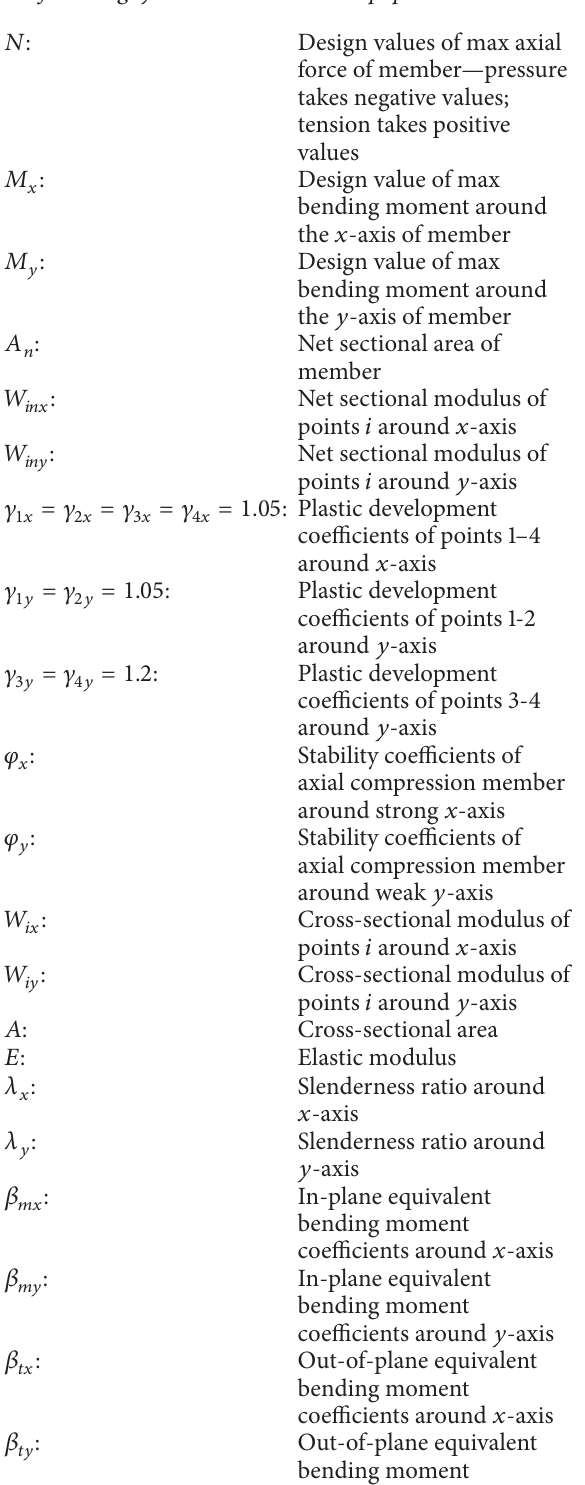
table test and numerical damage behaviour analysis of a steel portal frame with bolted connections,” Computers and